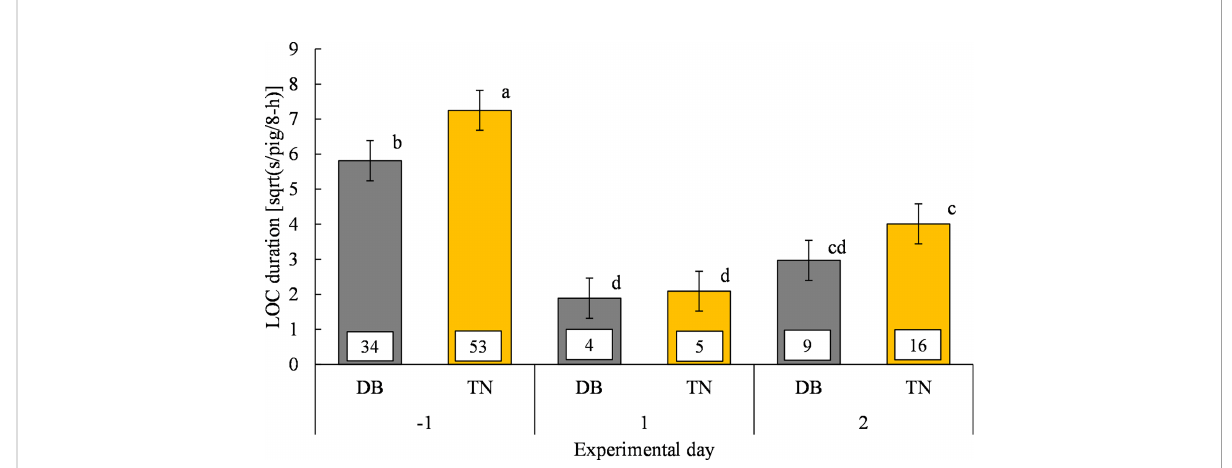
FIGURE 2 Time spent performing locomotor-rotational play (LOC), in s/pig/8-h, in DanBred pigs (DB; gray bars) or Topigs Norsvin TN70 pigs (TN; yellow bars) between 14:00 h and 22:00 h on days − 1, 1, and 2 relative to weaning. The bars represent least squares means and the error bars indicate standard error. Estimates and standard error bars were square root transformed prior to analysis, and the back-transformed least squares means are shown within a box on the top of each bar. Different superscript letters indicate statistical difference at p < 0.05 both between and within